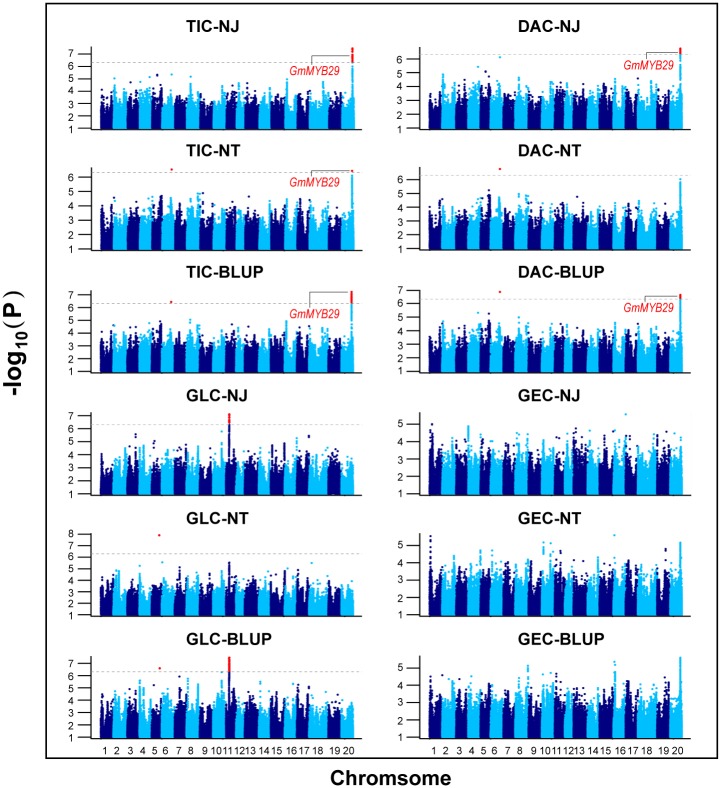
Manhattan plots of the GWAS for total isoflavone contents (TIC), daidzein contents (DAC), glycitein contents (GLC), and genistein contents (GEC) in the NJ environment, the NT environment and the BLUP data set across these two environments.